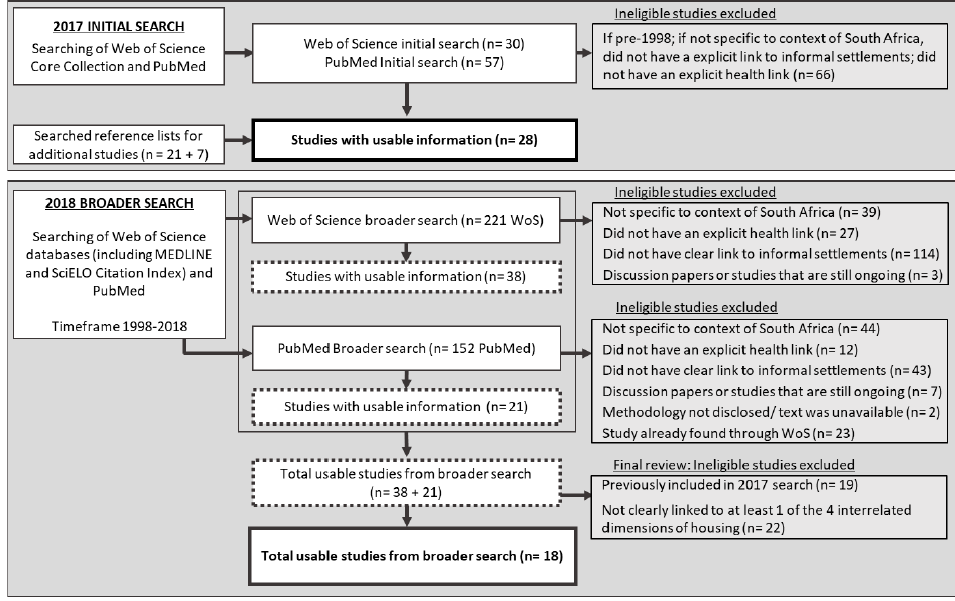
Figure 1. Flow Diagram of search steps .